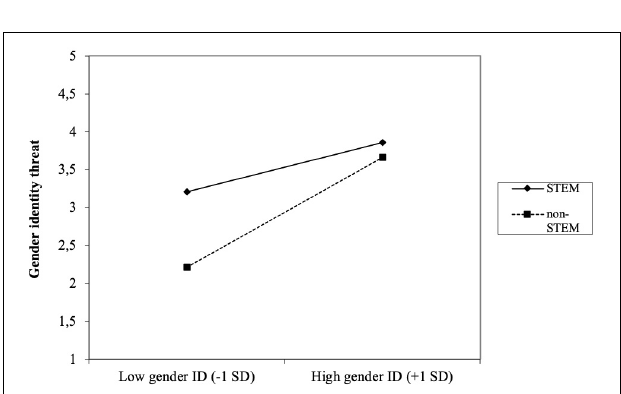
FIGURE 3 | Two-way interaction-effect gender ratio × work sector (STEM vs. non-STEM) on gender identity threat among women.